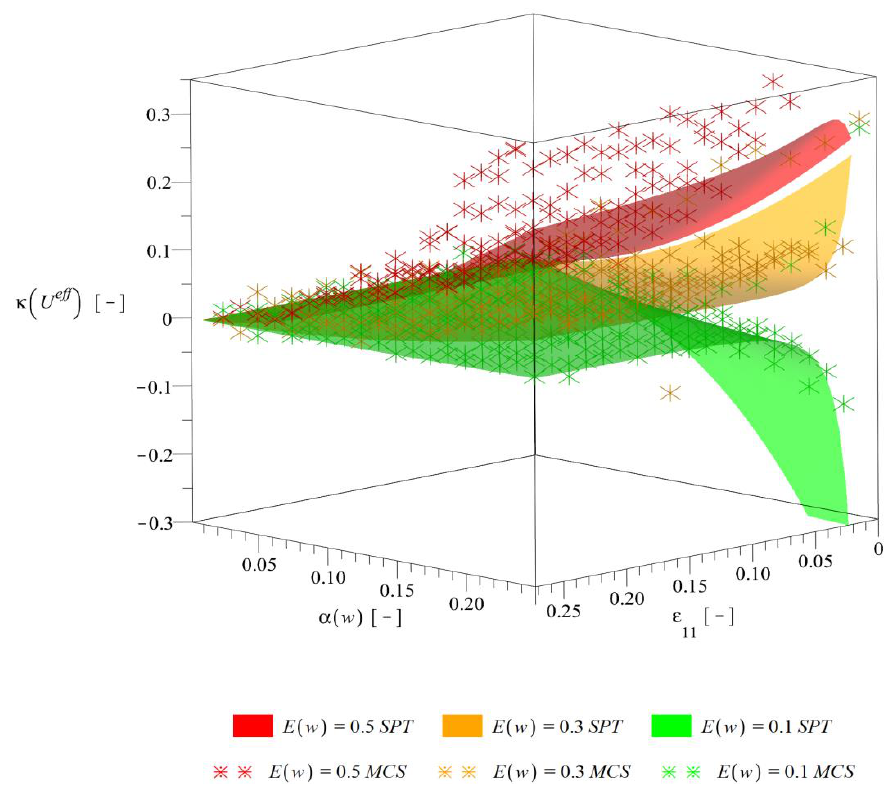
(cid:16) (cid:17) U ef f